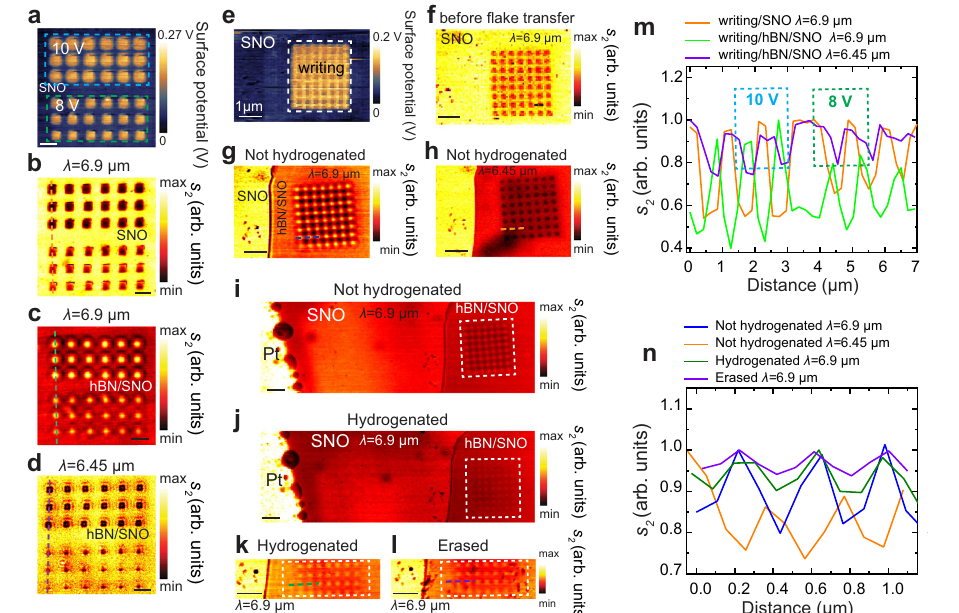
fl aketransferredontopofthepatternimagedat g λ =6.9 µ mexcitationwavelength and at h λ =6.45 µ m. i Near- fi eld second harmonic amplitude, s 2 , images of the conductive patternonhBN/SNO and Ptelectrodeshown onthe leftof the patterns before H 2 exposure i , after H 2 exposure j , zoomed in image after H 2 exposure k followed by erasing made byapplying 10V potentialat the c-AFM tip( l ). m Near- fi eld second harmonic amplitude, s 2 , line pro fi les extended along the dashed lines in panels b – d (orange, neon green, and violet, respectively). n Near- fi eld second harmonic amplitude, s 2 , line pro fi les extended along the dashed lines in panels g , h , k , and l (blue, orange, green, and violet respectively). White dashed lines in panels e , i , j , k , and l represent the charge written region on SNO. All scale bars indicate 1 µ